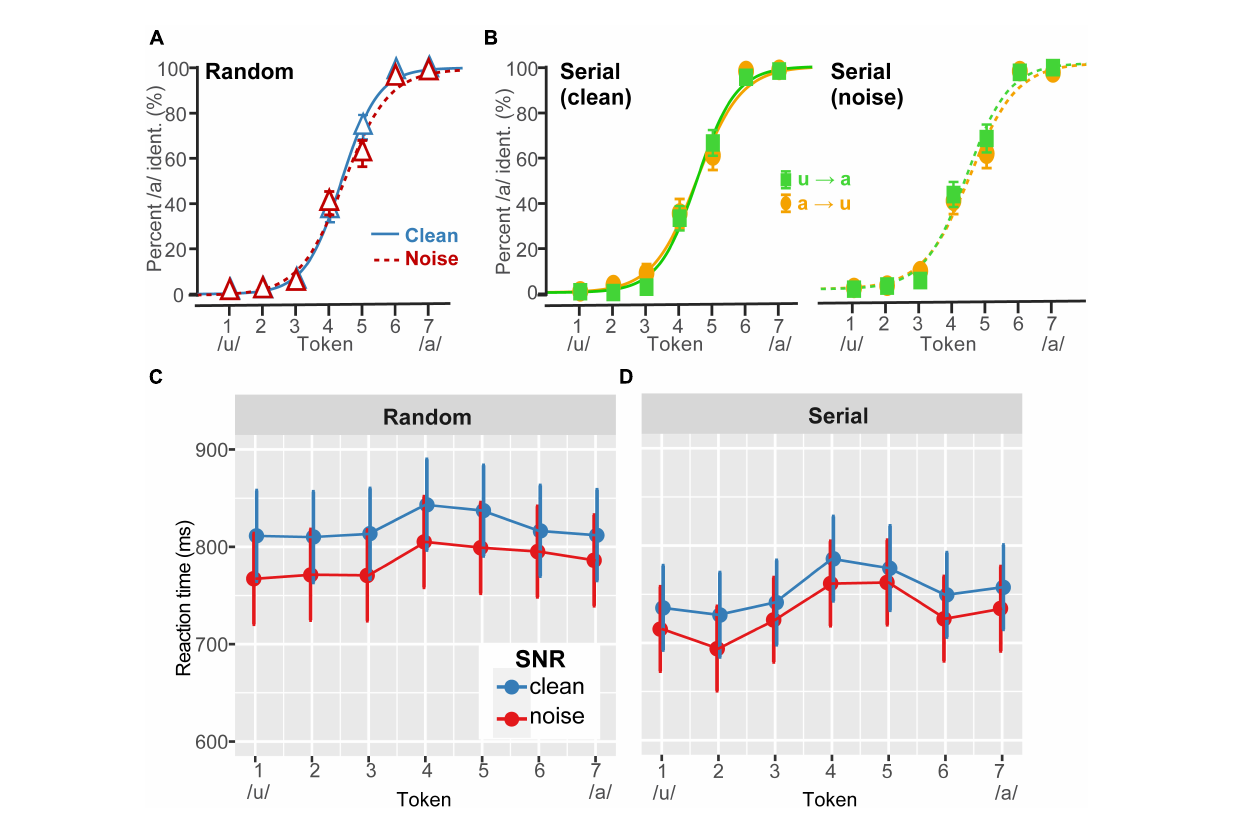
FIGURE1 Perceptual warping in behavioral vowel identification. (A) Grand average perceptual psychometric functions for clean and noise-degraded speech identification. Noise (0 dB SNR) had minimal effect on categorical hearing. (B) Grand average comparison of (clean) vowel identification under forward (u → a) vs. reverse (a → u) serial ordering of the continuum (similar patterns were observed in noise). Warping was not prominent in the grand average data and is largely washed out at the group level (cf. the strong differences at the individual data, Figure 2 ). (C,D) Speech labeling speeds (RTs) for phenome identification. Listeners were faster at labeling continuum tokens under (i) noise vs. clean listening conditions and (ii) serial vs. random presentation. RTs also showed the typical slowing of responses near the continuum’s midpoint where category membership is ambiguous (Pisoni and Tash, 1974; Bidelman and Walker, 2017). Error bars = ± 1 SEM (A,B) ; 95% CI (C,D) .